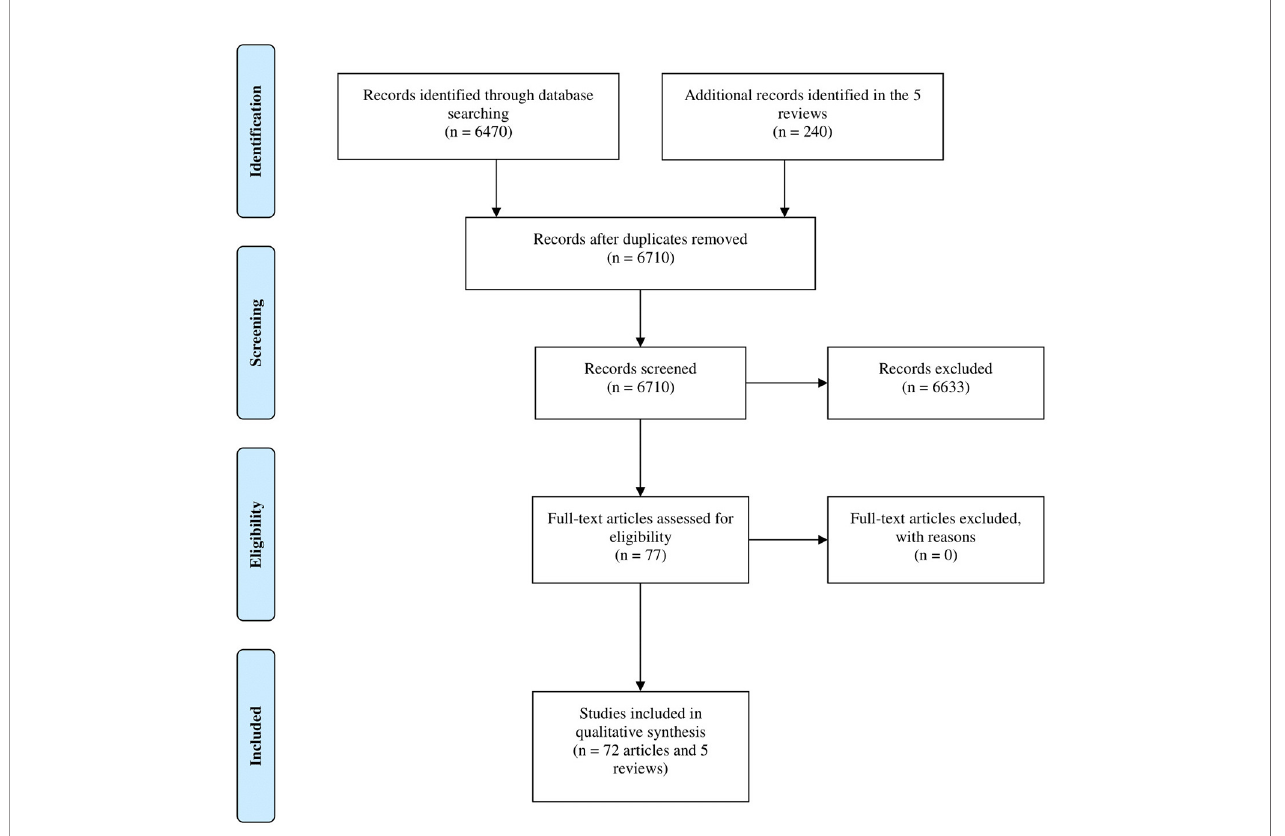
FIGURE 2 | Study fl ow diagram.